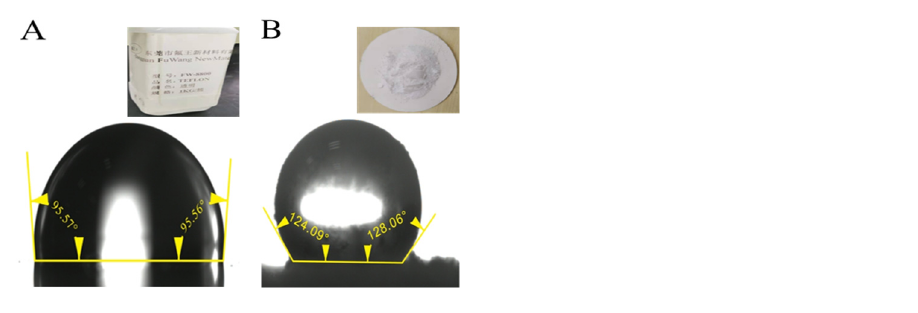
Figure 1. The static contact angle data of the aluminum alloy polished flat substrate sprayed with FW-8800 and hydrophobic nano-SiO 2 particles. The illustration is the real object. ( A ) FW-8800; ( B ) hydrophobic nano-SiO 2 particles.